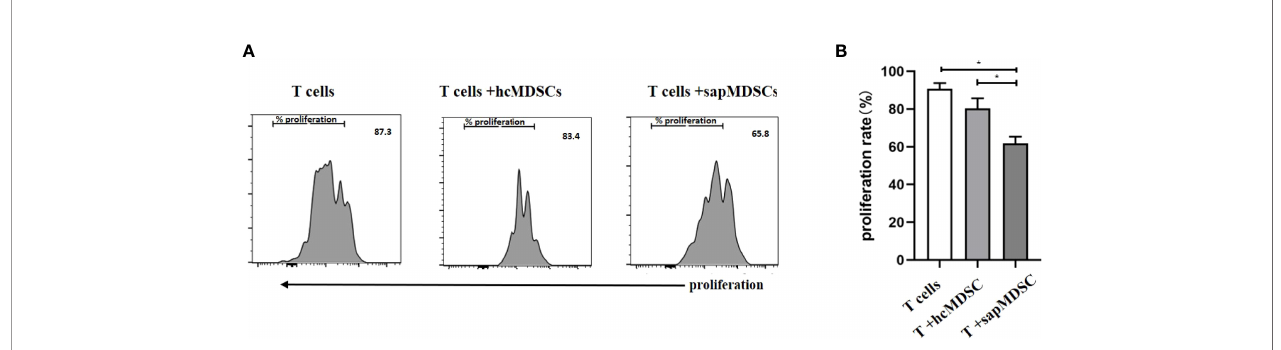
FIGURE 6 | The inhibition of MDSC in peripheral blood from HCs and patients with SAP. (A, B) MDSCs from patients with SAP had increased inhibitory ability to CD3+ T cell proliferation compared to HCs. hcMDSCs, MDSC from healthy control; sapMDSC, MDSC from patients with SAP. CD3+ T cells were cultured or co- cultured with MDSC from HC or SAP patients for 5 days, and CD3+T cells proliferated. * P < 0.05. The experiment was repeated three times, and the data were expressed in the form of (mean + SD). The Student ’ s t test was used for statistical analysis.